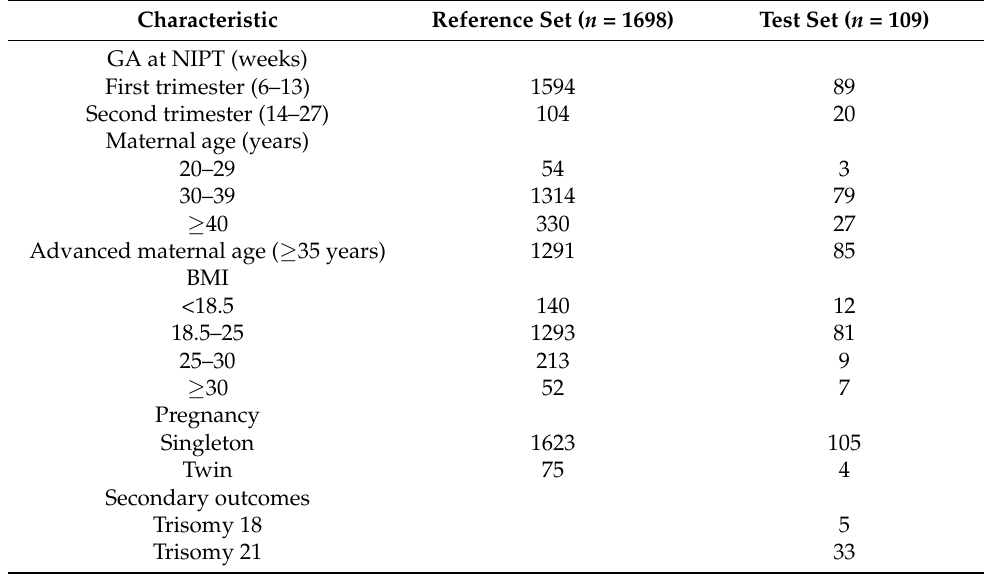
Table 1. Demographic characteristics of the reference and test